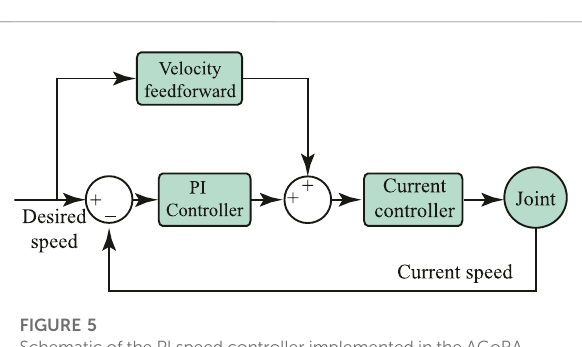
FIGURE 4 Experimental setup for the gain tuning of the AGoRA exoskeleton ’ s low-level controller.